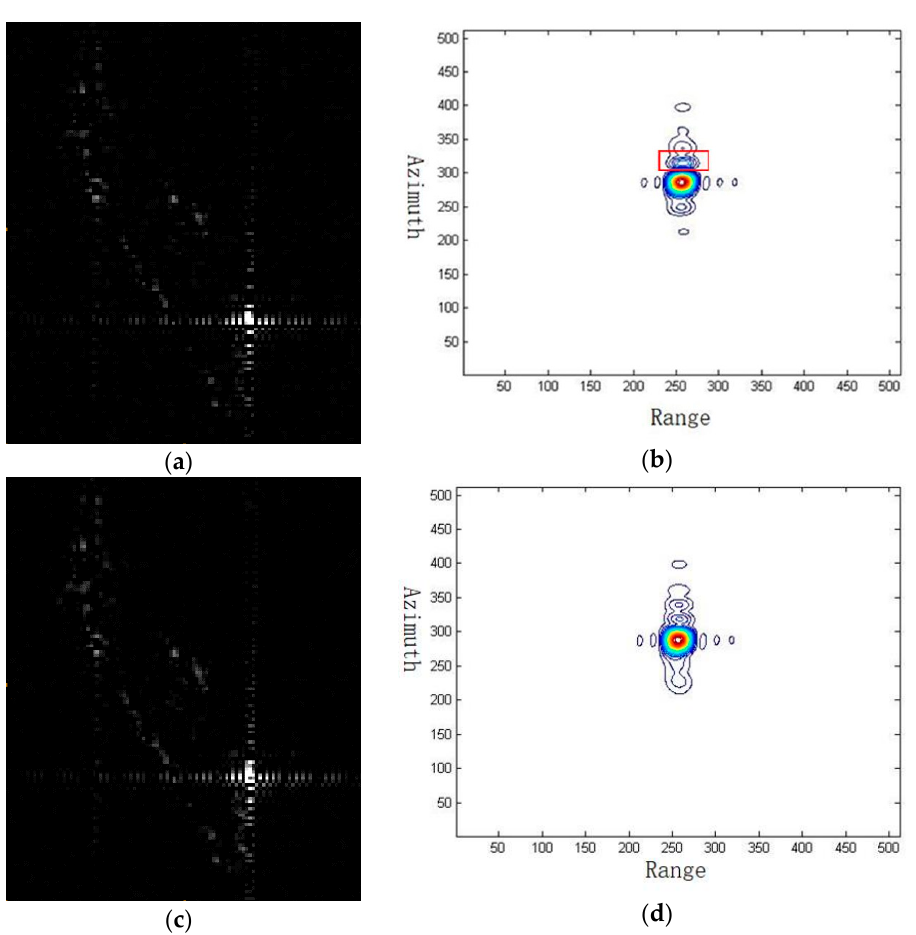
Figure 8. Nonstandard target result chosen from Figure 6. ( a ) Image by conventional two-step processing. ( b ) Contour by conventional two-step processing. ( c ) Image by modified two-step processing. ( d ) Contour by modified two-step processing.